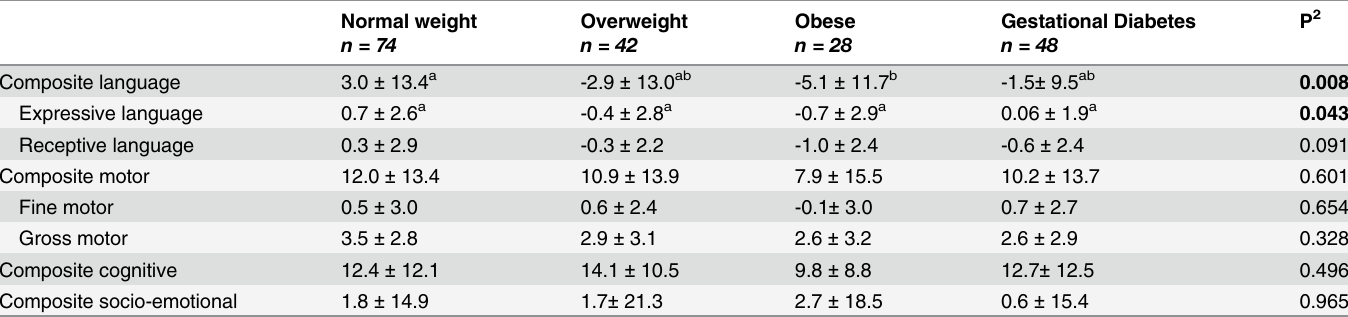
Table 5. Raw difference 1 in Bayley III scores between 6 and 18 months of age in the four